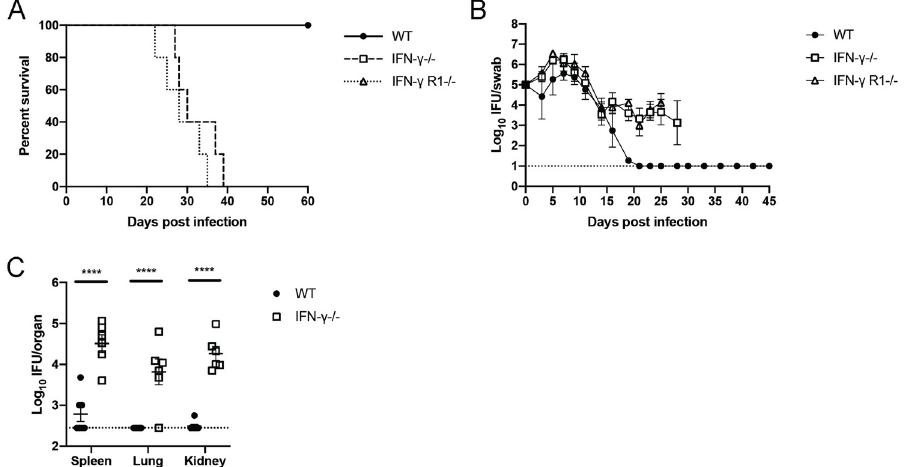
Fig 5. IFN- γ -deficient mice die from systemic disease, but clear the majority of FRT infection. Mice received 2.5mg Depo-Provera 7 days before infection with 1x10 5 IFU Chlamydia muridarum i.vag. (A) Survival curve. (B) IFU per vaginal swab over time of mice from (A). IFN- γ -/- and IFN- γ Receptor-/- data was truncated at days 28 and 25 respectively when the number of mice surviving dropped below 50%. n = 5 for all groups in (A) and (B). Results are shown as mean with SEM. (C) Bacterial load per organ on day 14 (2-way ANOVA). Data is compiled from two separate experiments with n = 3 and 4 per group, though one IFN- γ -/- mouse died prior to day 14 and could not be included. ���� = p <